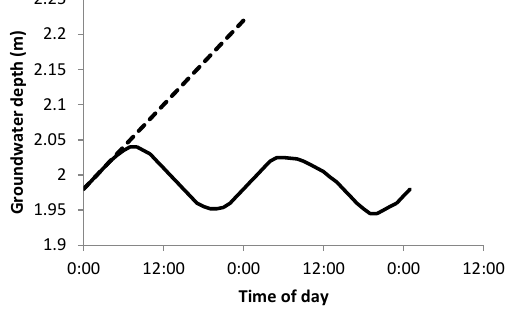
Figure 4. An idealised representation of changes in depth-to- groundwater over a 48h period. The water table declines (depth increases) during the day because of transpiration by vegetation but increases (depth decreases) at night when transpiration tends to zero and recharge exceeds loss. The dashed line represents the trajectory of overnight recharge in the absence of transpiration on the follow- ing day. See text for further discussion of